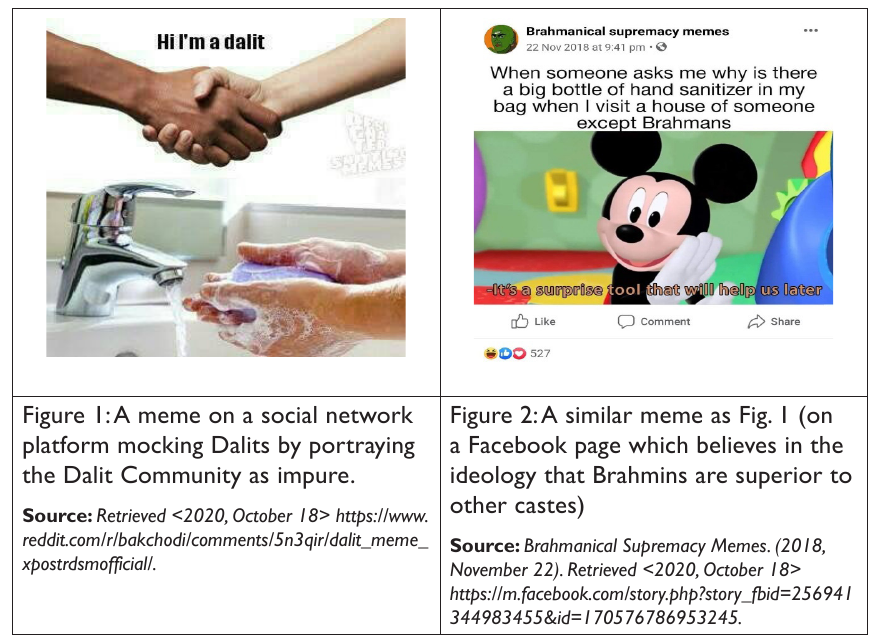
Figure 1: A meme on a social network platform mocking Dalits by portraying the Dalit Community as impure.